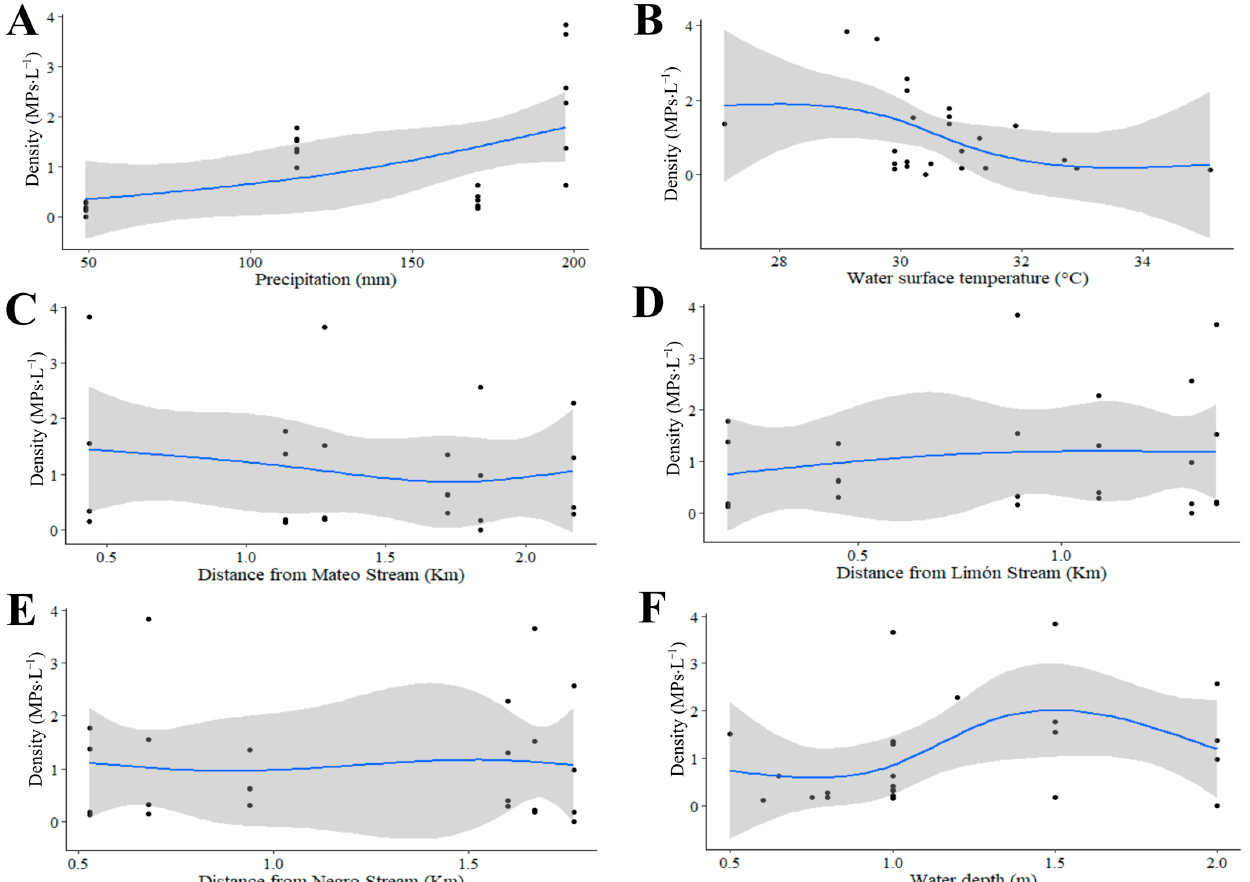
Figure 4. Relationship between the density of microplastics (MPs·L − 1 ): ( A ) precipitation (mm), ( B ) surface temperature of the water, ( C ) distance from the Mateo stream (km), ( D ) from the Limón stream (km), ( E ) from the Negro stream (km), and ( F ) depth of the water (m), through a generalized additive analysis ( p -value see Table 2). Shaded areas indicate 95% confidence intervals, and black dots represent observed data. Table 2. Effects estimated by the Generalized Additive Model of the density of microplastics in surface water in the Luruaco Lake, p -value: *** (<0.01), ** (<0.05), * (<0.1).